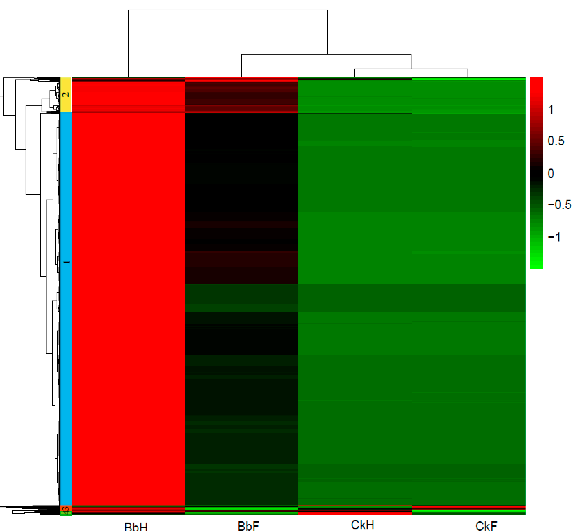
Figure 5. Hierarchical clustering analysis of mutual DEGs in fat body and hemocytes of E. oblique larvae.